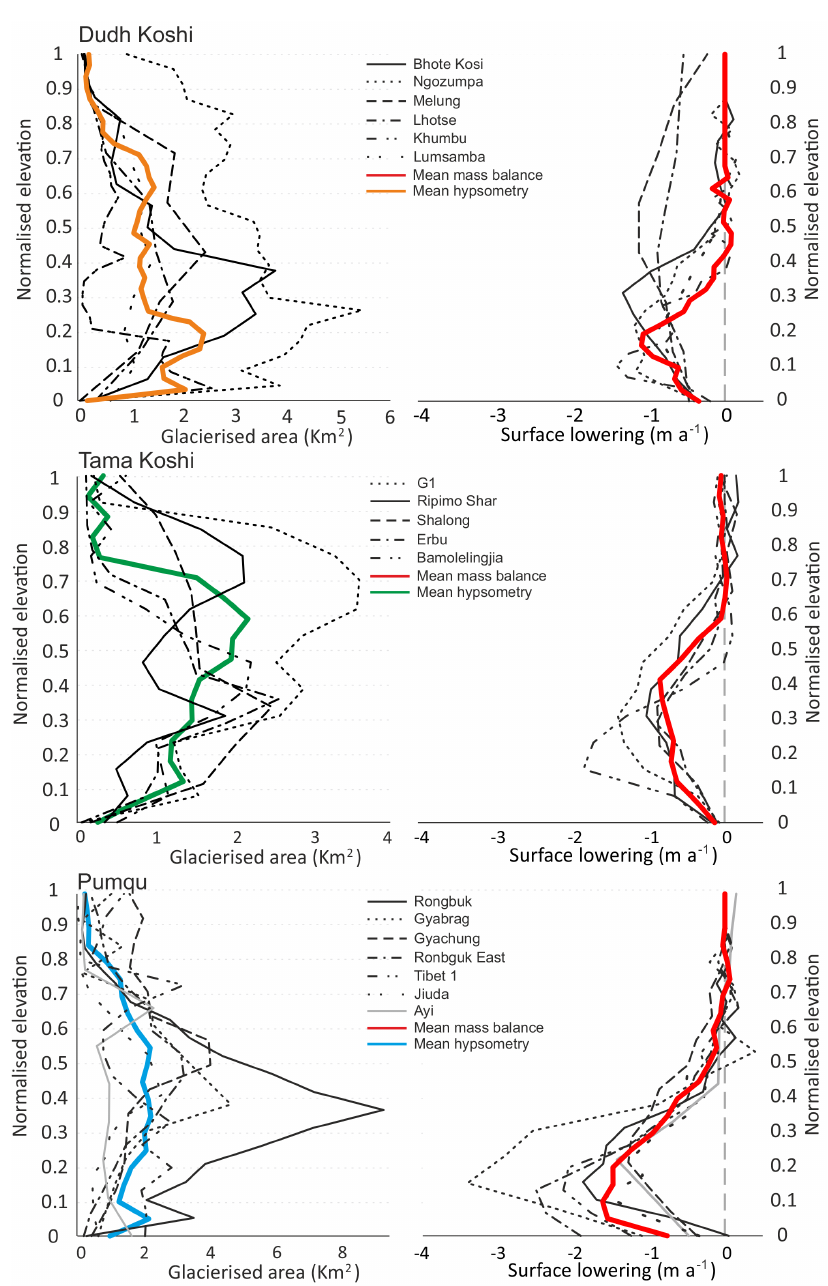
Figure 5. Surface elevation change and glacier hypsometry curves for all land terminating glaciers in the three different catchments of the study